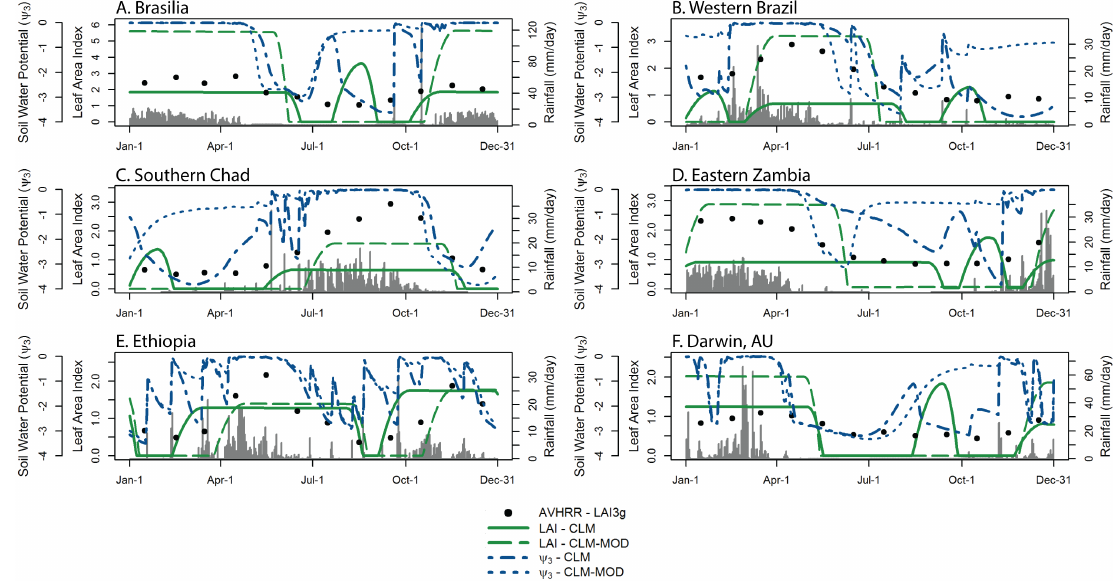
Figure 3. Seasonal cycles of rainfall (mmday − 1 , gray bars), leaf area index (LAI, green lines and black dots) and soil water potential in the third layer (MPa, blue lines) in CLM and CLM-MOD for 1 year (2001).